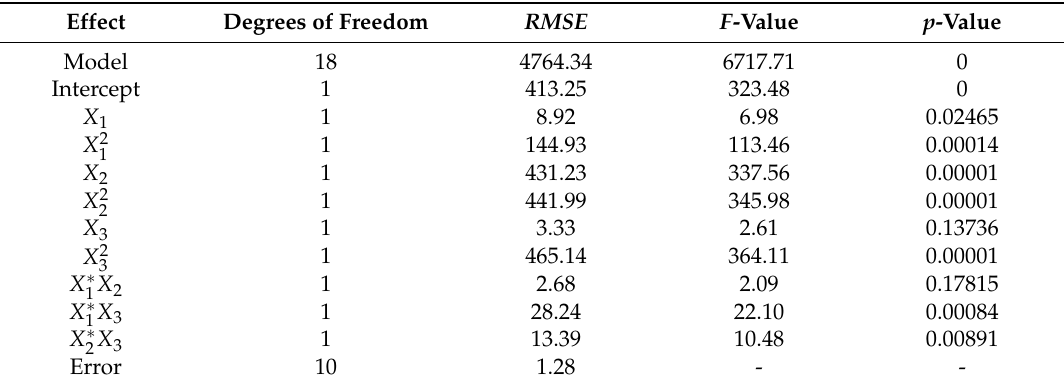
Table 6. ANOVA for the model